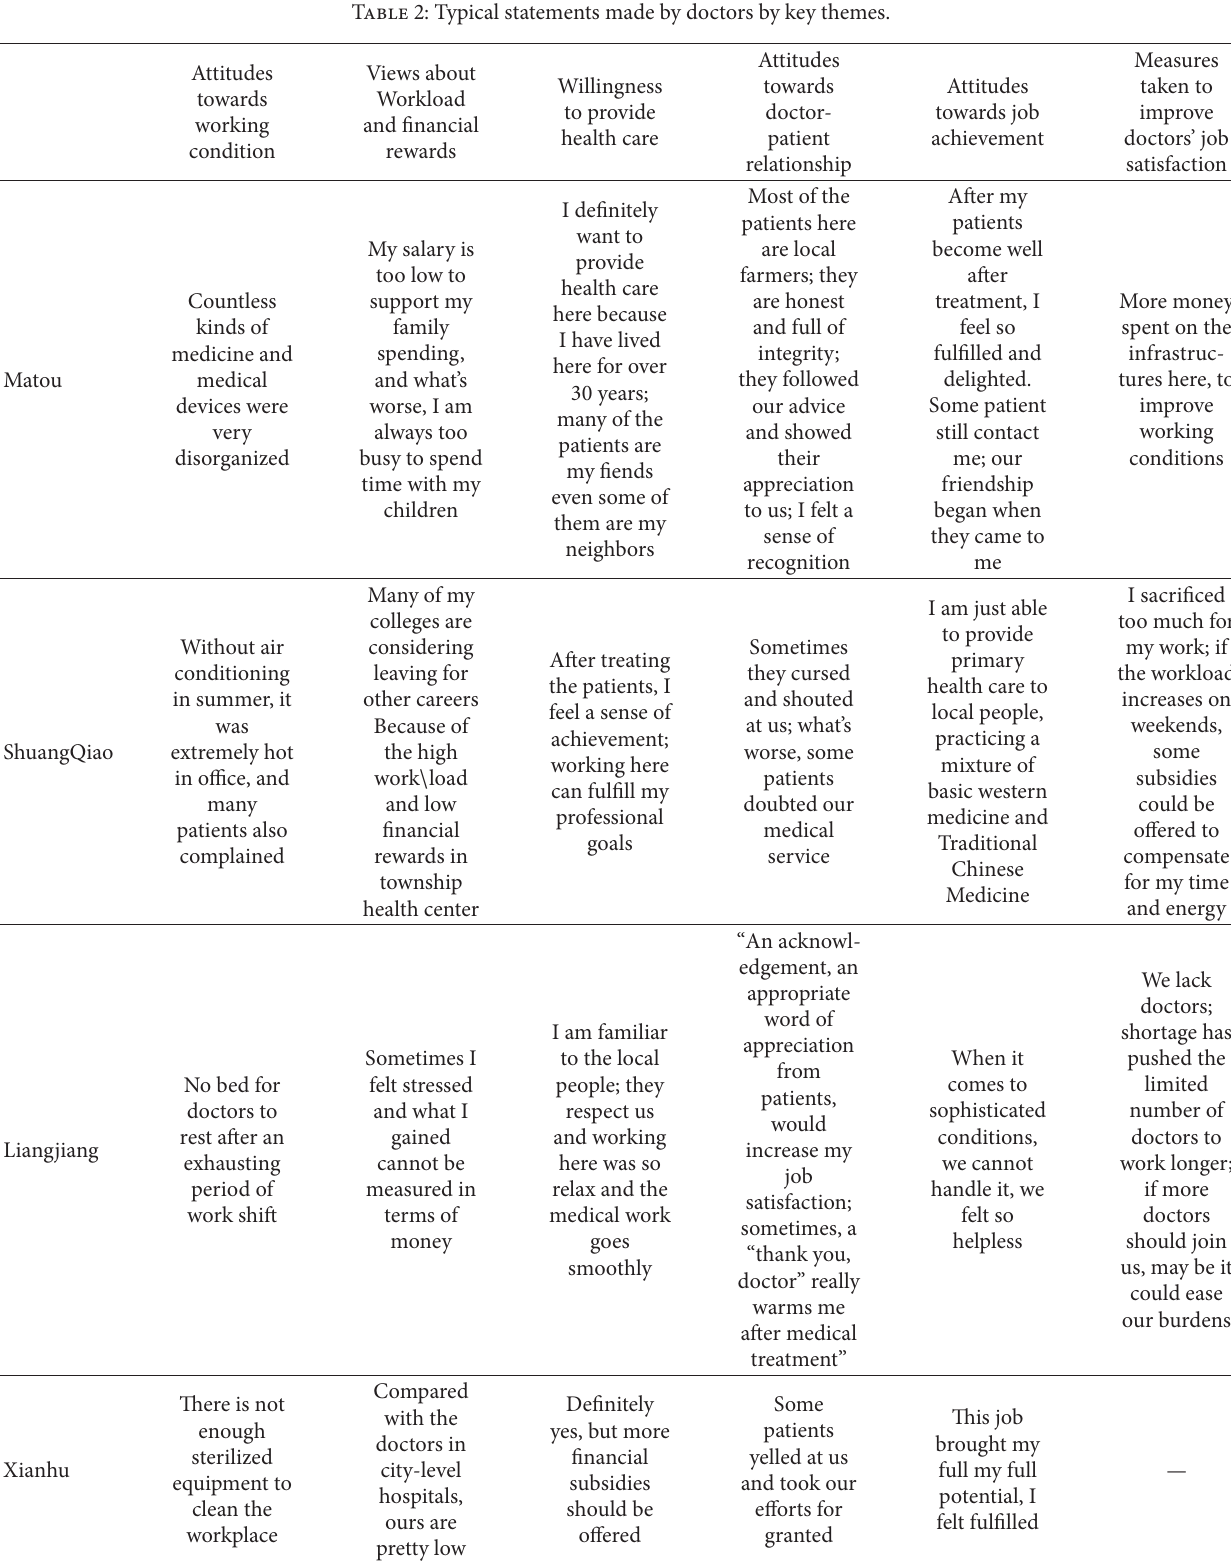
Table 2: Typical statements made by doctors by key